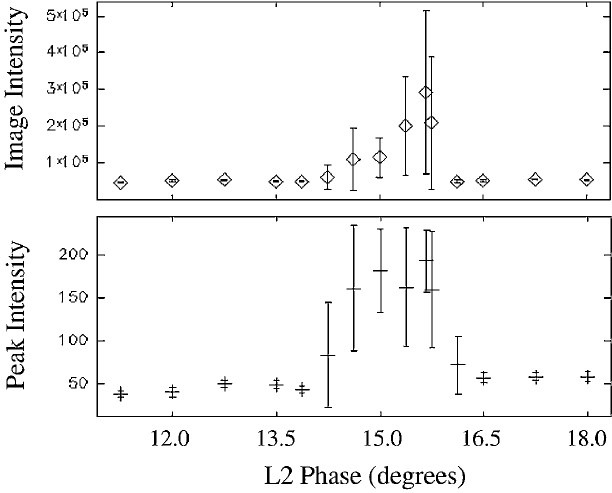
FIG. 7. Plot of the OTR image integrals (top) and OTR peak intensities (bottom) versus L2 phase (degrees). The enhance- ments occur near the FIR CTR signal maximum.